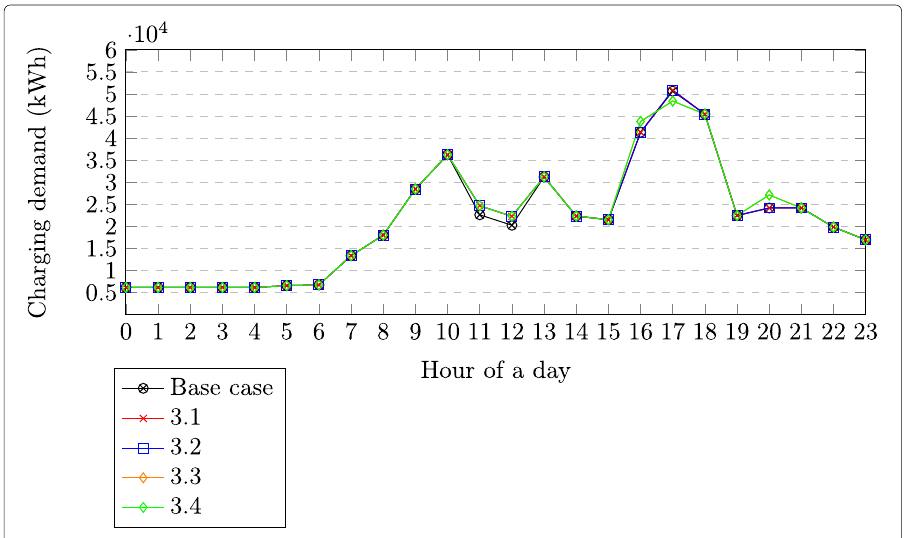
Fig. 9 Comparison of charging demand in the base case and in scenario that climate awareness is